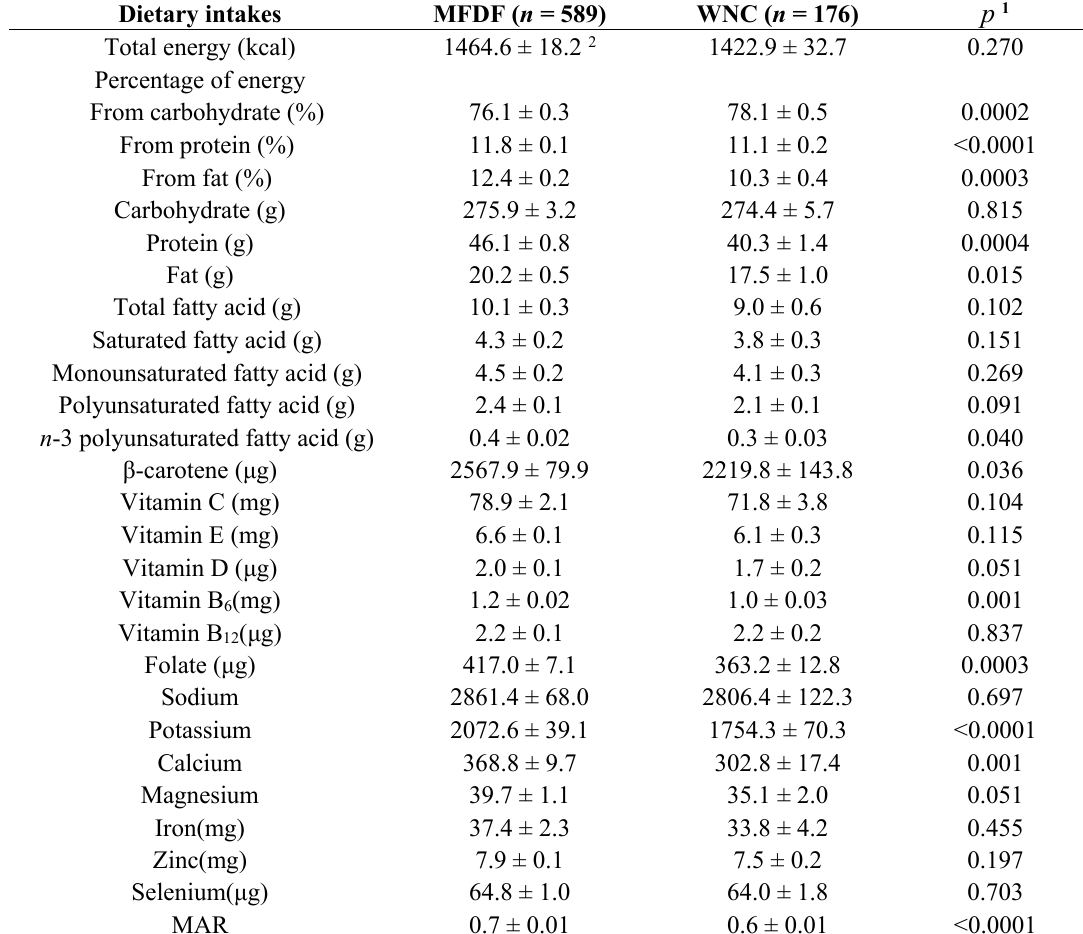
Table 3. Nutrient intake of participants in the two dietary patterns.